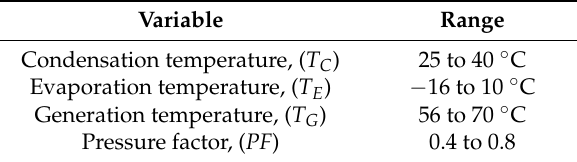
Table 2. Operation range of selected variables for the half-effect cycle.